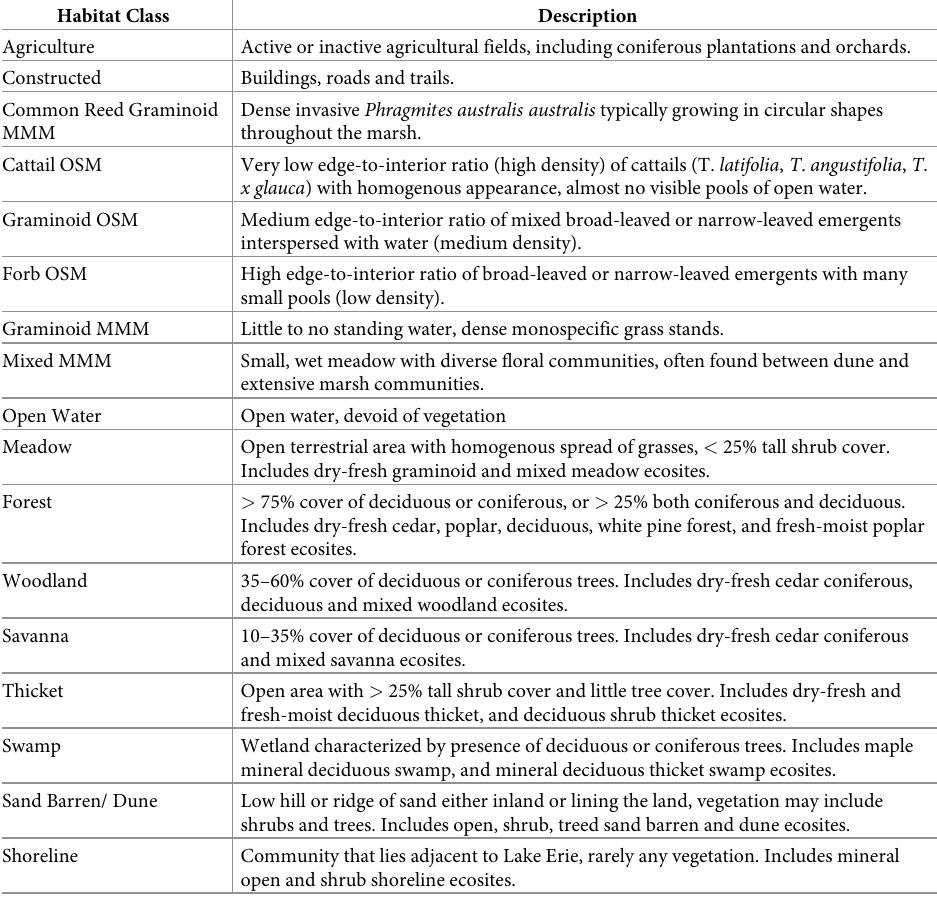
Table 2. Habitat types classified in image data for Point Pelee National